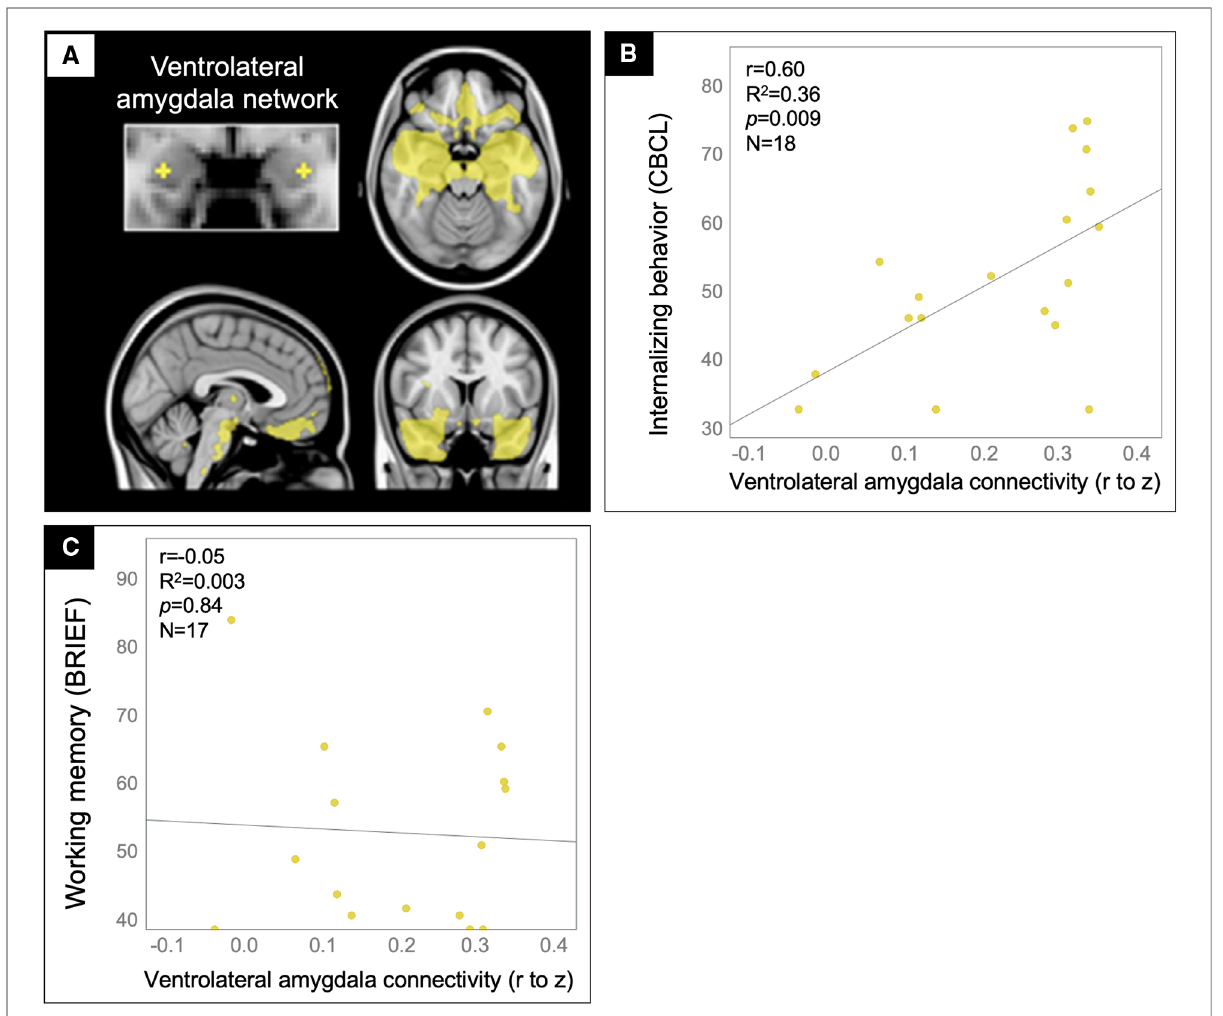
FIGURE 4 Ventrolateral amygdala hyperconnectivity predicted internalizing problems but not working memory problems for patients in the TBI group. Scatter plots showing the correlation between ventrolateral amygdala ( A ) rFC values (x-axis) and the CBCL Internalizing problems ( B ) and BRIEF Working memory ( C ) scale ratings (y-axis) with statistics for the Pearson correlation